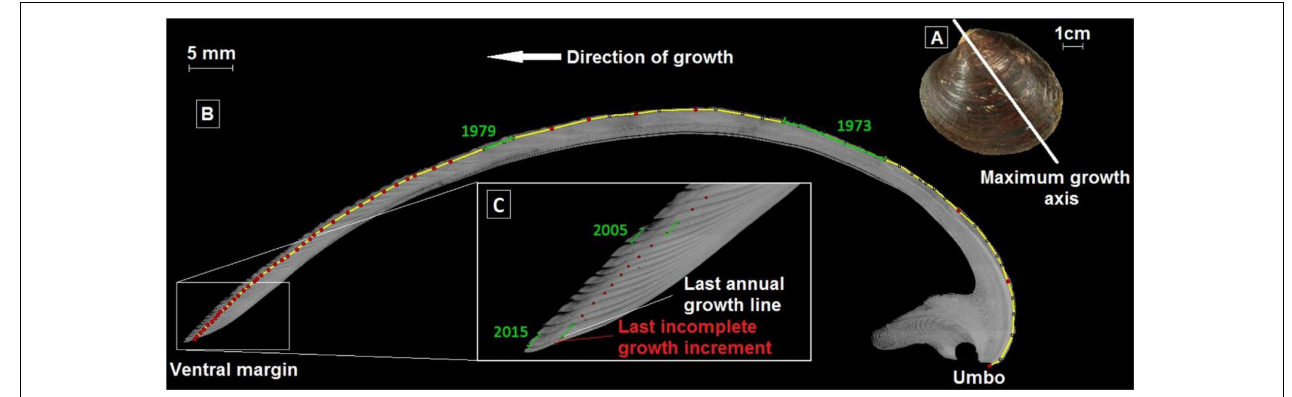
FIGURE 2 | Arctica islandica growth patterns. (A) Outer shell surface of an A. islandica left valve and its axis of maximum growth along which thin cross sections were cut. (B) Photomosaic of a cross-section stained by Mutvei’s solution, and (C) zoom on the ventral margin to observe the last annual growth line and 2016 incomplete growth increment. The yellow line corresponds to the trajectory on which annual growth lines (red dots) were placed and growth increments measured (green